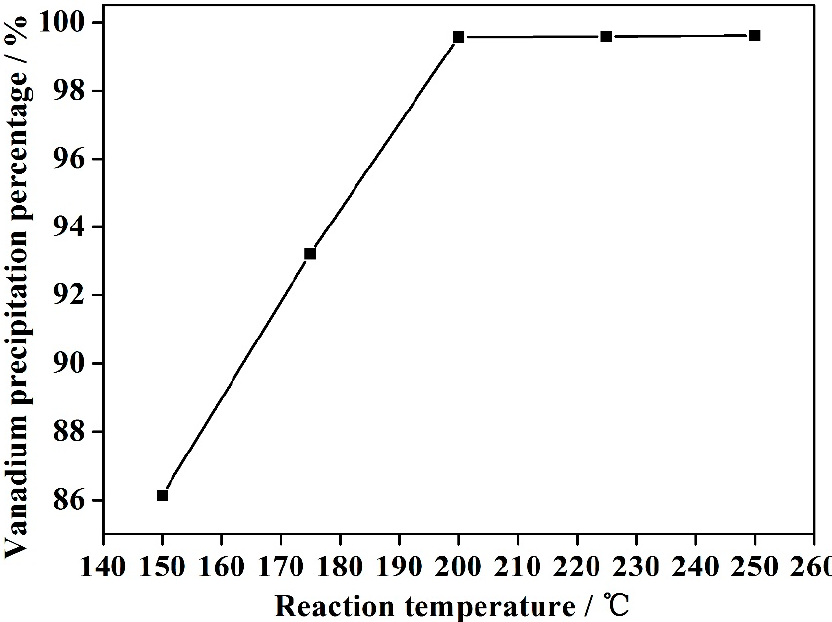
Figure 5. The effect of reaction temperature on vanadium precipitation percentage.